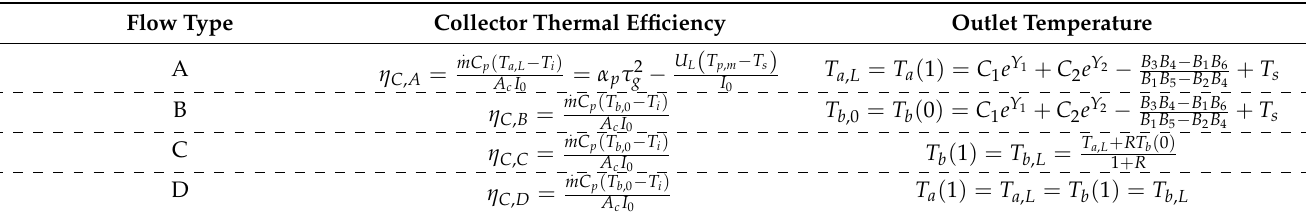
Table 2. Theoretical predictions of the collector thermal efficiency and outlet temperature for all flow